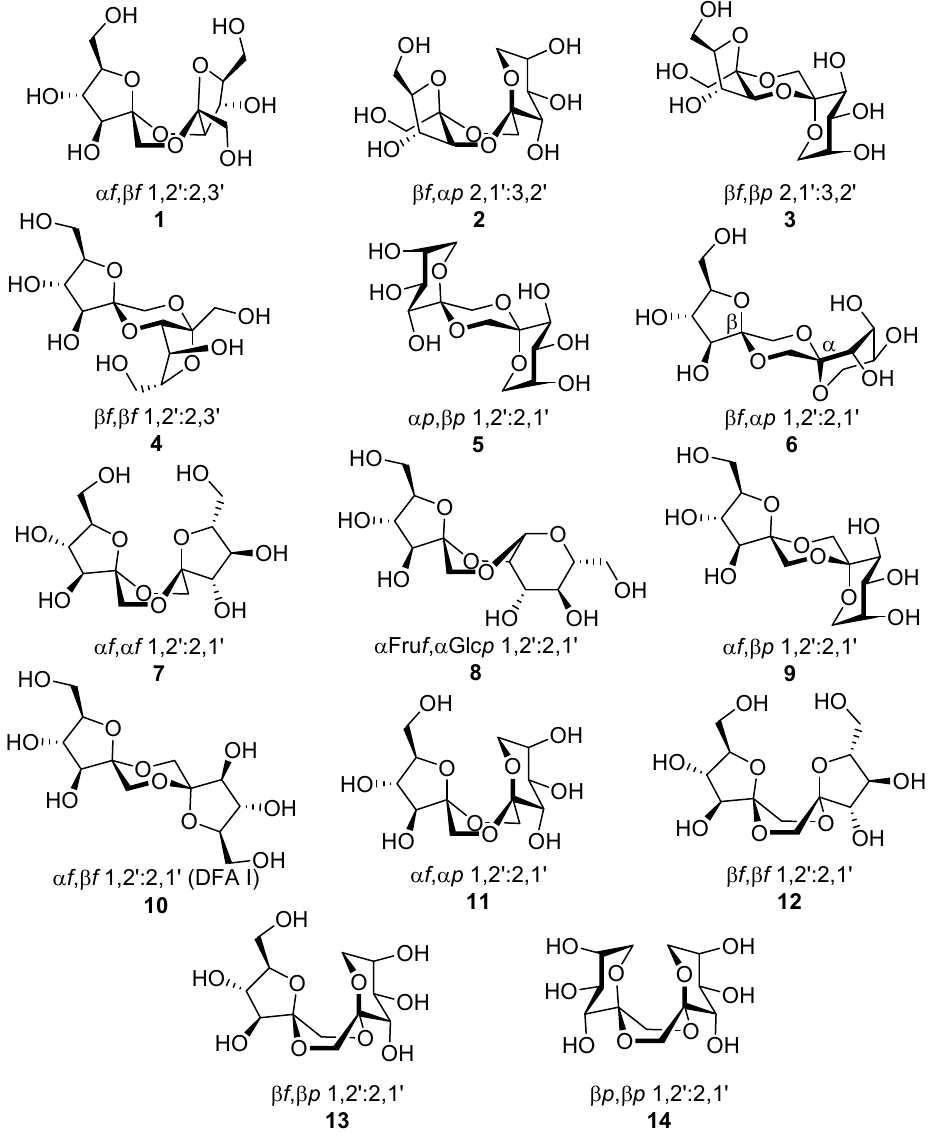
Figure 1 . DFA structures identified in the disaccharide fraction of fructose and sucrose